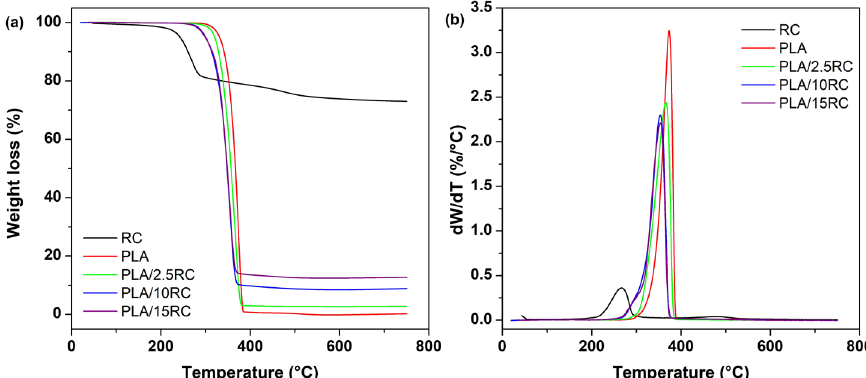
Figure 7. (a) Thermogravimetric analysis of RC and injection molded samples, (b) DTG curves of RC and injection molded